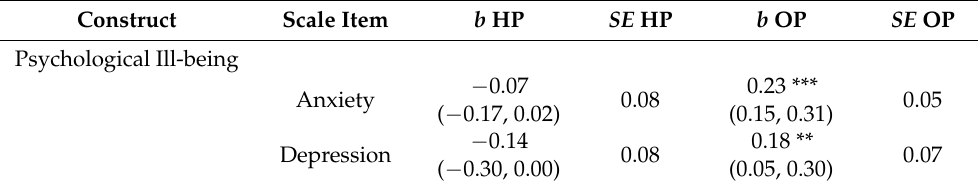
Table A2. Results of the Bootstrapped Regression Analyses that Violated